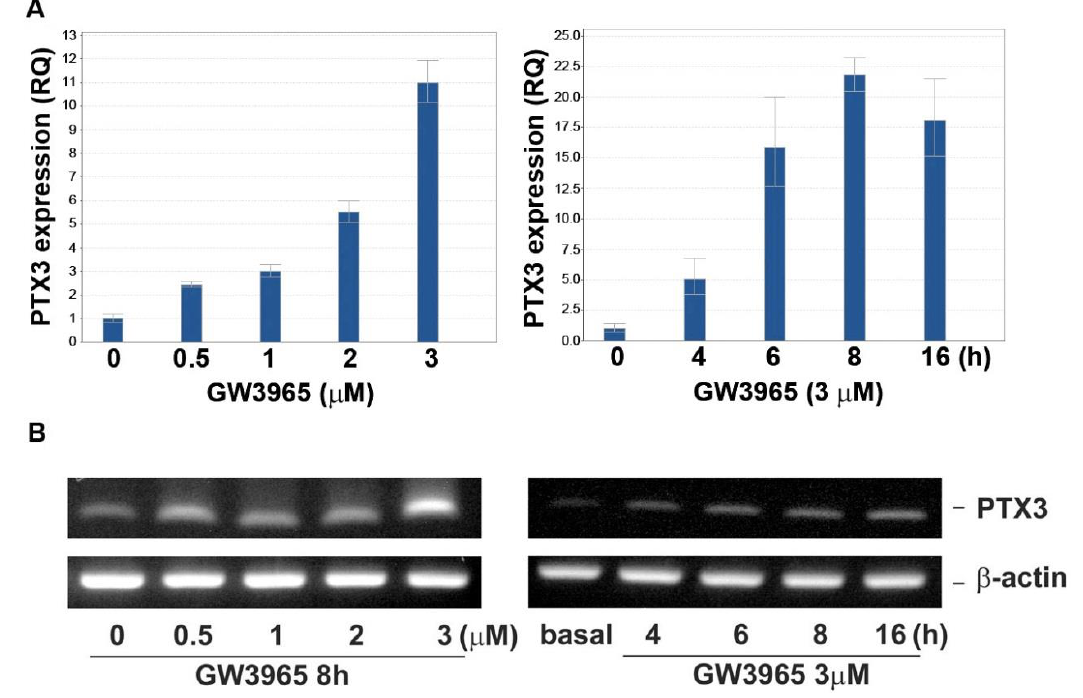
Figure 4. GW3965 induces ptx3 mRNA expression. The human fibroblasts were challenged with GW3965 for 8 h or GW3965 for the time periods. ( A ) Real-time PCR and ( B ) reverse transcription polymerase chain reaction (RT-PCR) were used to measure the ptx3 mRNA level ( n = 3).